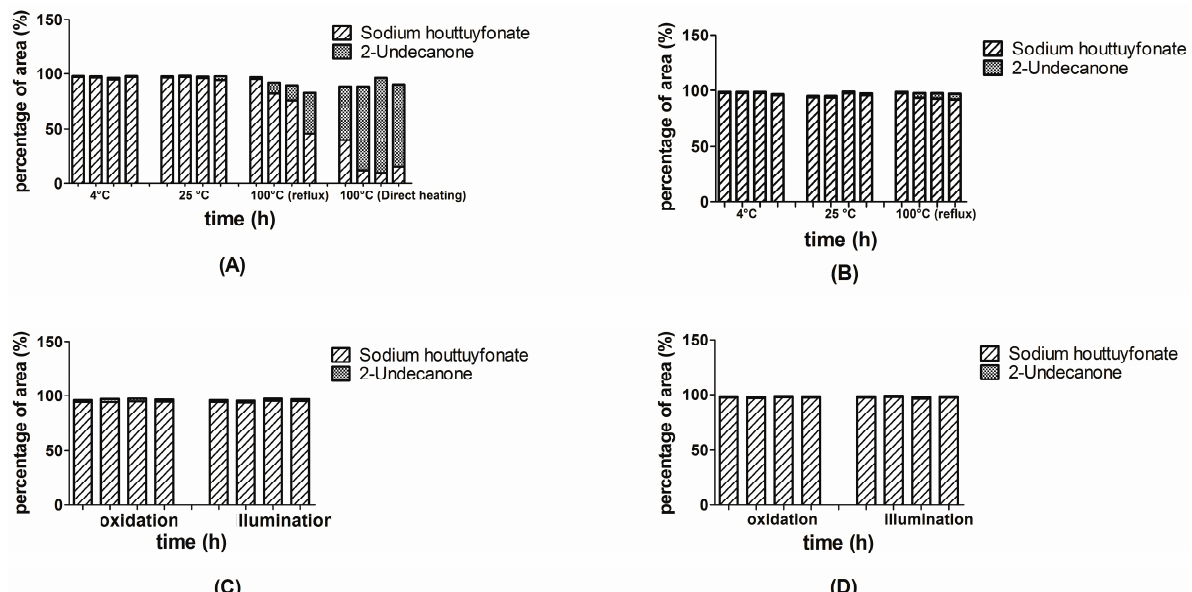
Figure 5. Stability (temperature, oxidation and illumination) of sodium houttuyfonate and 2-undecanone in different solvents. Four columns of each group from left to right were measured for 0.5, 1, 2 and 4 h, respectively. ( A ) temperature (in aqueous solution); ( B ) temperature (in ethyl acetate); ( C ) oxidation and illumination (in aqueous solution); and ( D ) oxidation and illumination (in ethyl